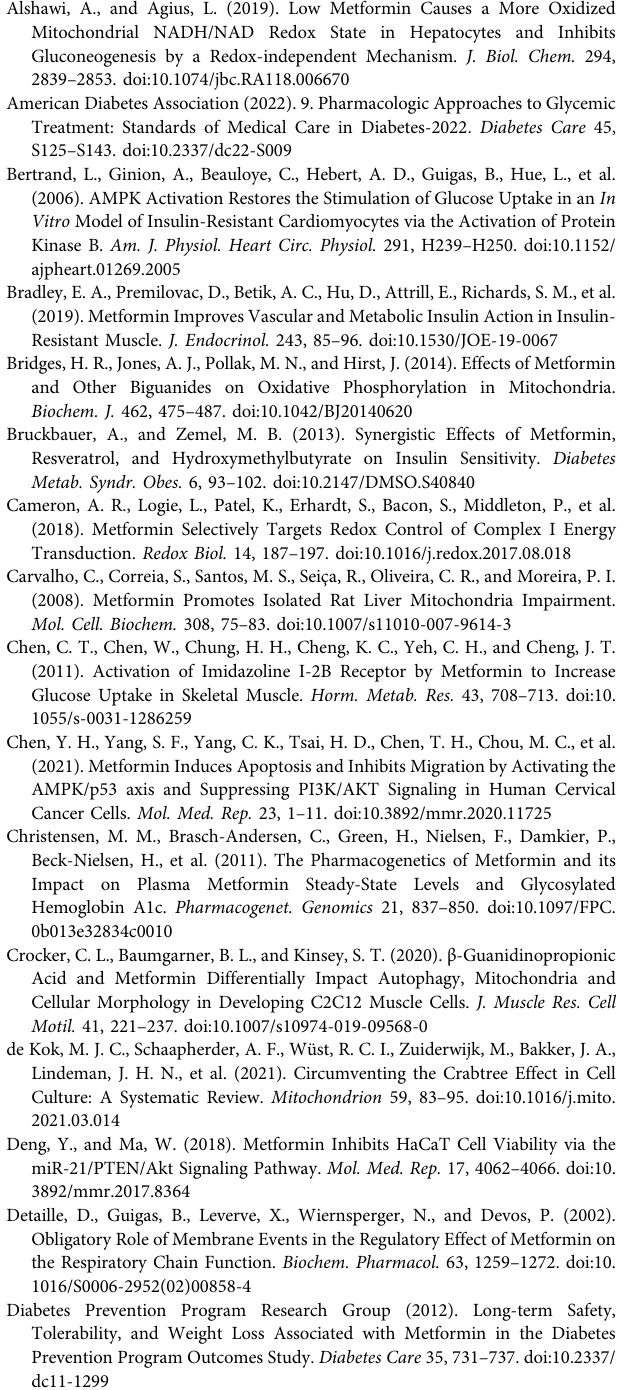
Supplementary Figure S1 | C2C12 cells were treated with metformin (50 and 5 mM)byaddingthetreatmentdirectlytotheinstrumentchamberandmitochondrial respiration of permeabilized cells was measured by high-resolution respirometry. ResultsforROUTINE (A) ,LEAK (B) ,OXPHOS-N (C) andOXPHOS-S (D) respiratory